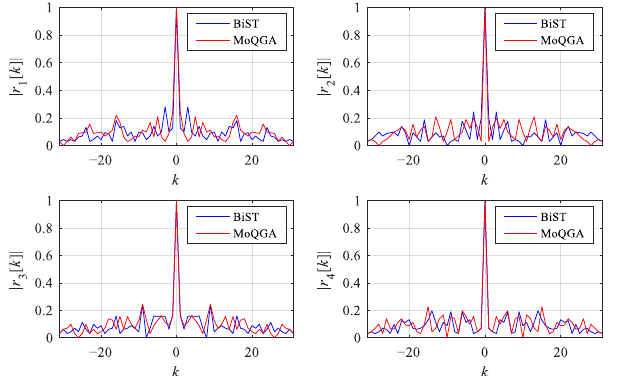
Figure 17. Auto-correlation functions of the waveform set obtained by MoQGA and BiST under M = 4, N = 32, and K = 4.